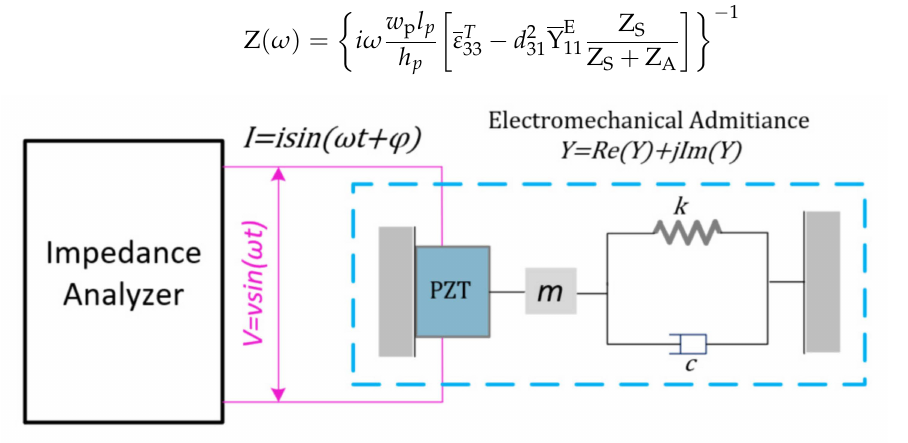
Figure 1. One dimensional model of electromechanical